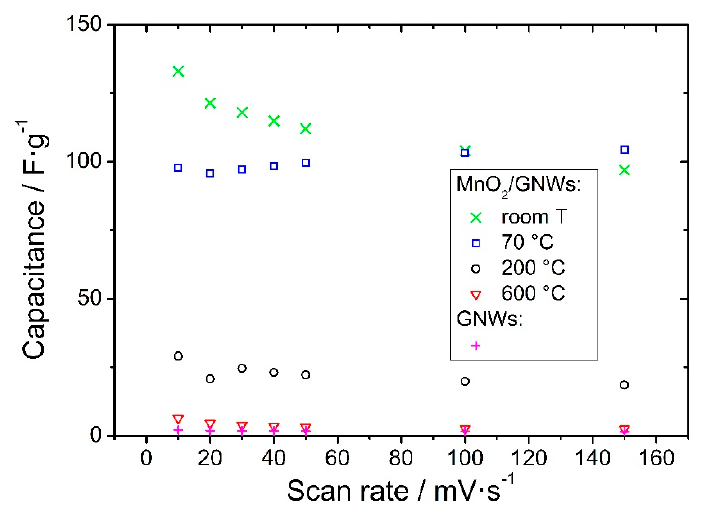
Figure 4. ( a ) Cyclic voltammograms of MnO 2 /GNWs sample annealed at 70 °C using scan rates 10, 20, 30, 40, 50, 100, and 150 mV s − 1 . ( b ) Bare GNWs and MnO 2 /GNWs sample annealed at 70 °C using a scan rate of 50 mV s − 1 and a voltage window between 0.0 to 0.7 V vs. Ag/AgCl. Arrows indicate the direction of the scan.